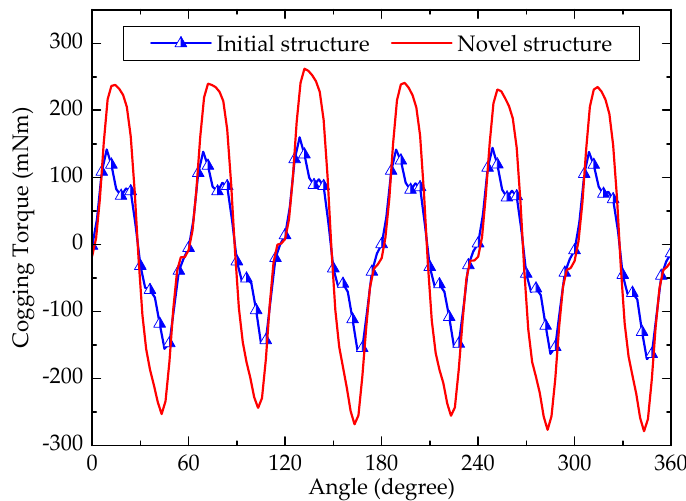
Figure 6. Cogging torque waveforms of the two FSPM machines.